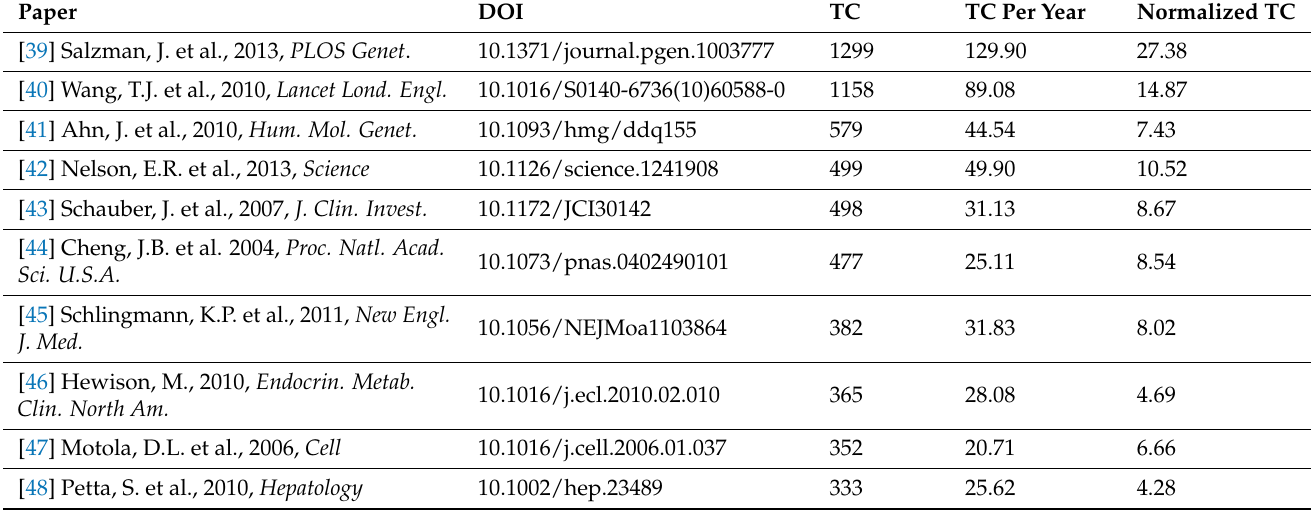
Table 1. Most globally cited documents about vitamin D metabolism gene polymorphisms (vitD- MGPs)